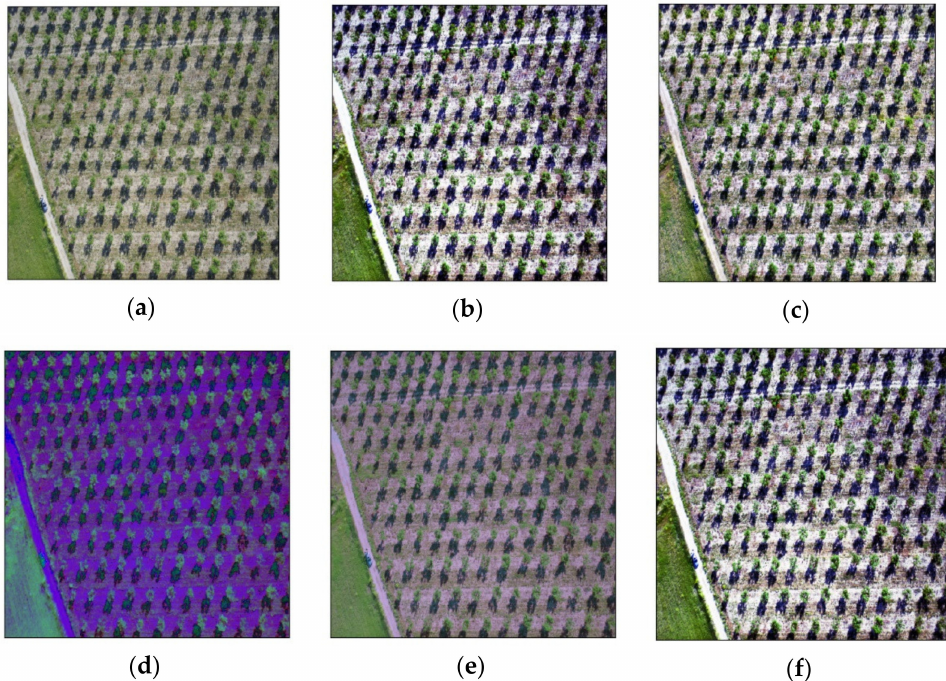
Figure 4. Image color transformations used in the study: ( a ) RGB image, ( b ) EQ image, ( c ) CLAHE image, ( d ) HSV colorspace image, ( e ) 6-channel RGB and HSV fused image, and ( f ) 6-channel CLAHE and HSV fused image.